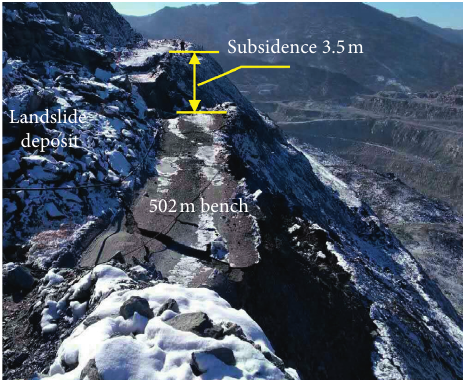
Figure 16: The overall subsidence of 502 level part steps.